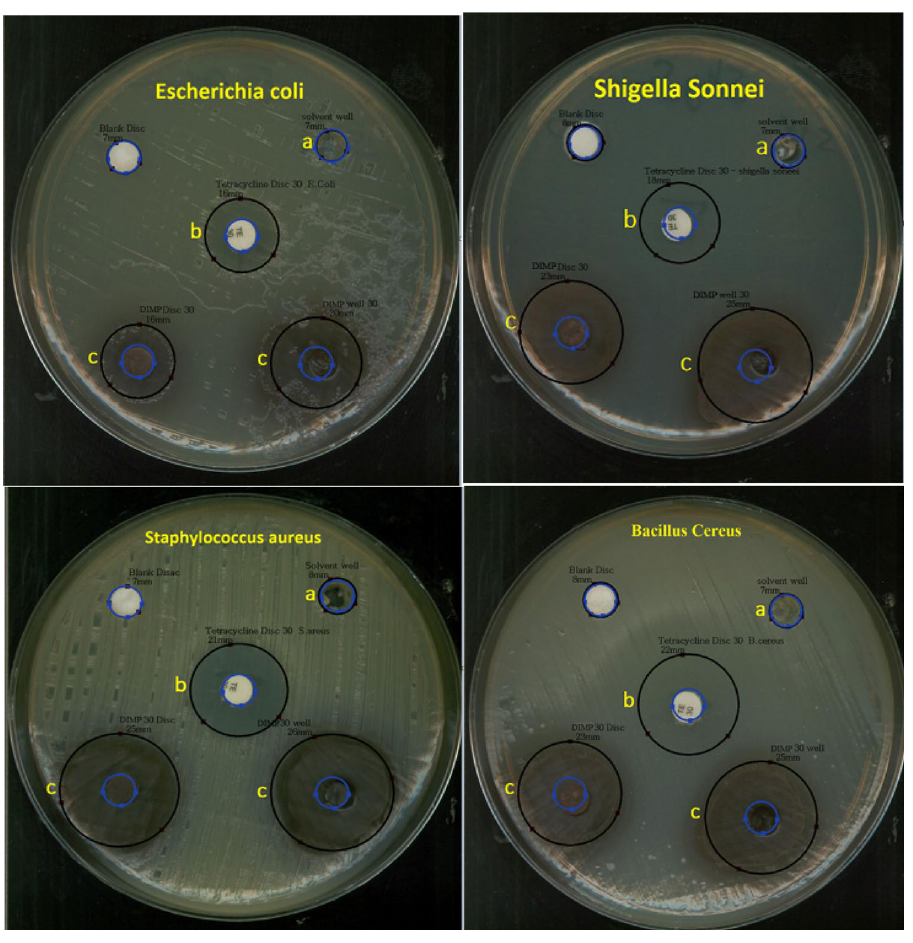
Figure 12. Inhibition zone diameters (mm) obtained of Bacillus cereus, Staphylococcus aureus, Escherichia coli and Shigella sonnei in disc diffusion test for 30 mg ml −1 of (a) solvent, (b) tetracycline and (c) DIMP.